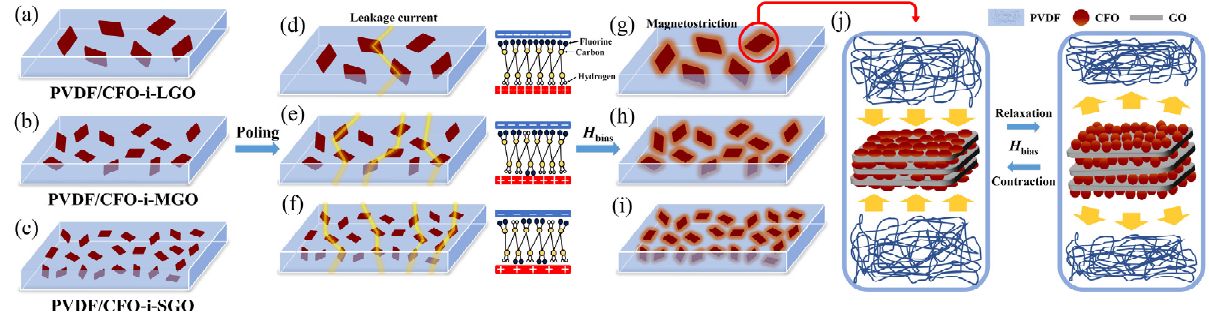
Figure 1. Schematic diagrams of the 3-2 type magnetoelectric (ME) films of ( a ) poly(vinylidene fluoride) (PVDF)/CFO-i- LGO (CoFe 2 O 4 -intercalated large-lateral-size graphene oxides), ( b ) PVDF/CFO-i-MGO(CoFe 2 O 4 -intercalated medium-lat- eral-size graphene oxides), and ( c ) PVDF/CFO-i-SGO(CoFe 2 O 4 -intercalated small-lateral-size graphene oxides); induced- leakage current in ( d ) PVDF/CFO-i-LGO, ( e ) PVDF/CFO-i-MGO, and ( f ) PVDF/CFO-i-SGO at a high electric field of 40 kV/mm; under an applied magnetic bias field ( H bias ) and active areas of magnetostriction in ( g ) PVDF/CFO-i-LGO, ( h ) PVDF/CFO-i-MGO, and ( i ) PVDF/CFO-i-SGO. ( j ) Conceptual illustration of z -axis magnetostriction in the 3-2 type ME films.